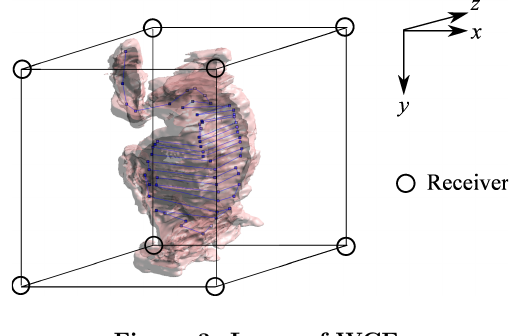
Figure 3: Locus of